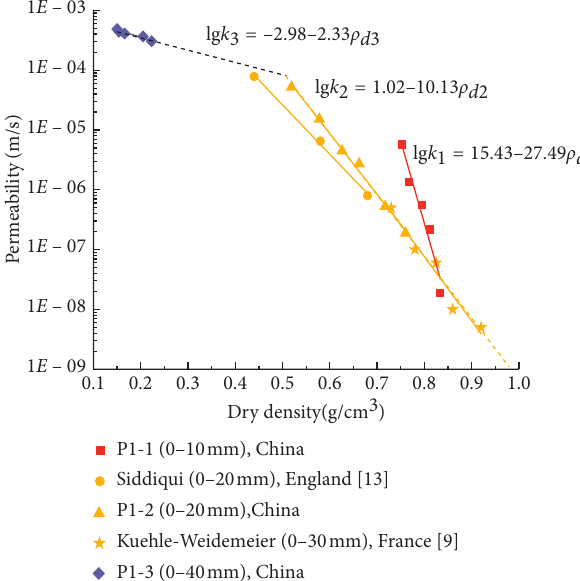
Figure 10: Comparison of permeability of MBT waste in China and some